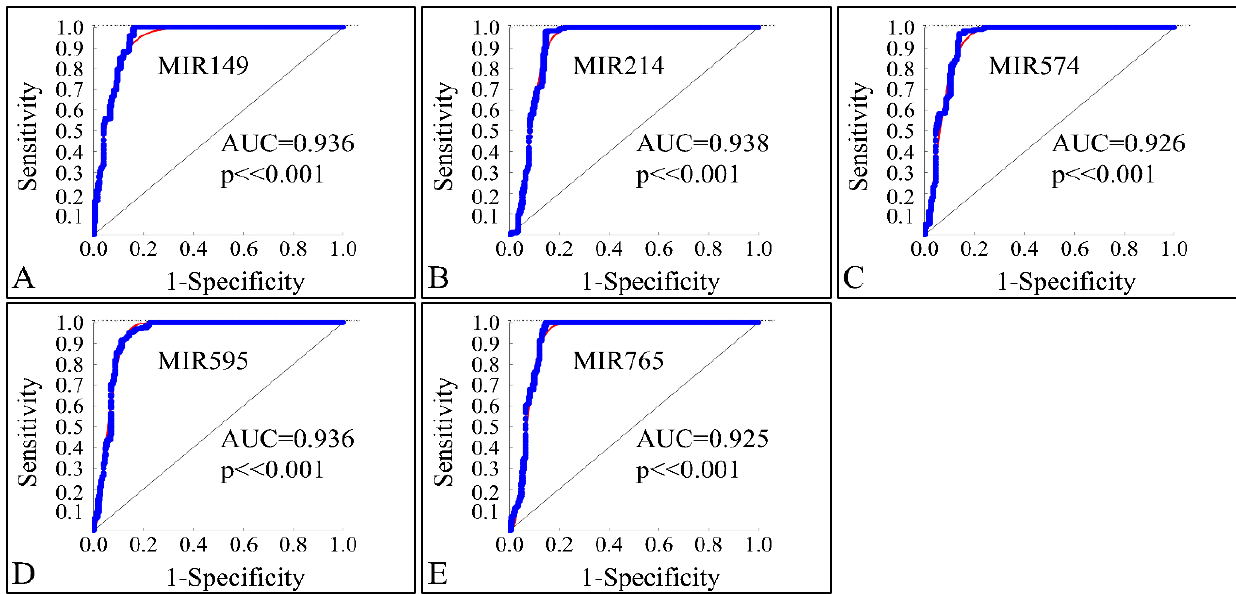
Figure 17. ROC analysis of MIR149 ( A ), MIR214 ( B ), MIR574 ( C ), MIR595 ( D ) and MIR765 ( E ). The miRNAs could successfully discriminate the controls and neoplasmatic CNS tumor samples with an area under the curve (AUC) ≥ 0.925 ( p < 0.001), corroborating their use as diagnostic markers (Legend: AUC: Area under the Curve).